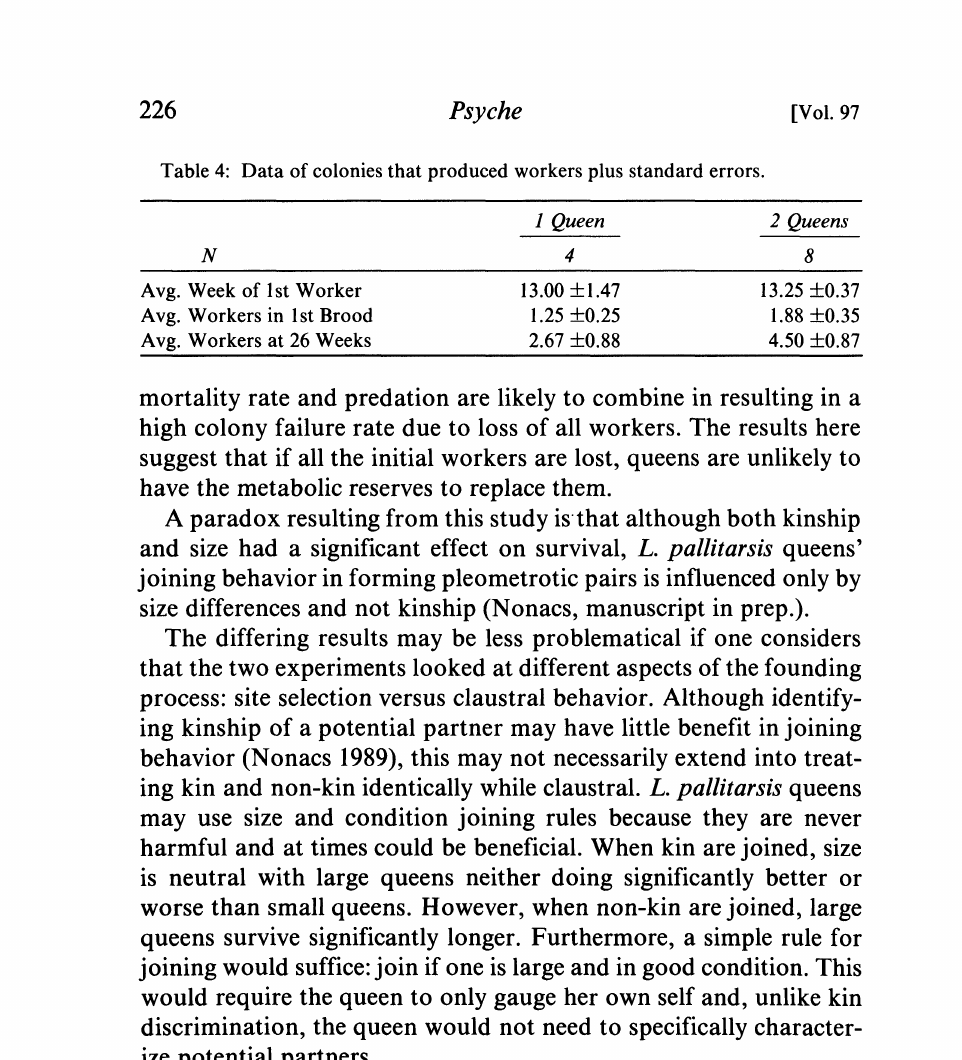
Table 4: Data of colonies that produced workers plus standard errors. 1 Queen 2 Queens N 4 8 Avg. Week of 1st Worker 13.00 Avg. Workers in 1st Brood Avg. Workers at 26 Weeks